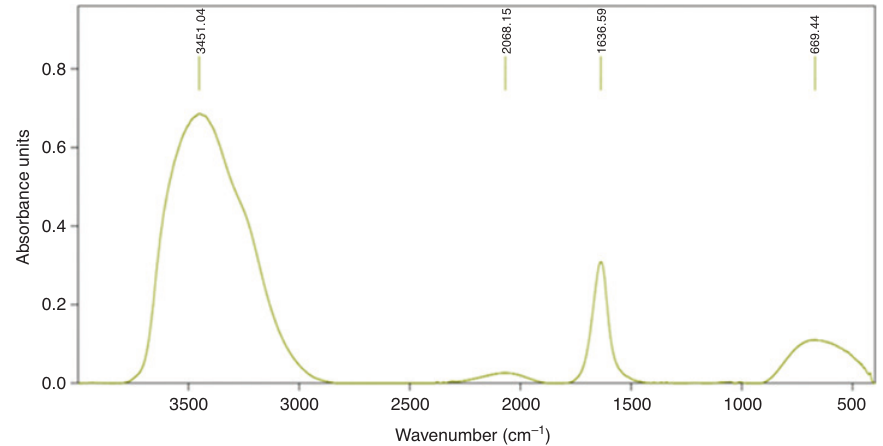
Figure 1: FT-IR spectrums of Pelargonium zonae leaf